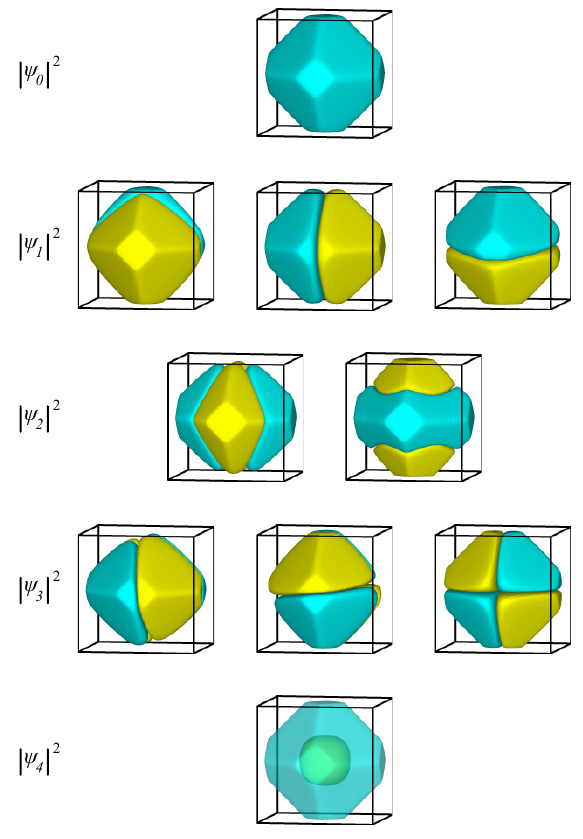
Figure 4. The probability function, | ψ | 2 , of the lowest-energy eigenstates of an electron inside a clean Au nanoparticle at equilibrium. Yellow represents positive and cyan negative values of the